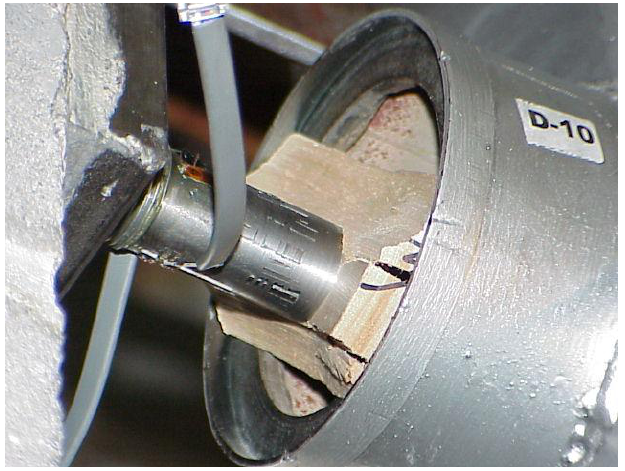
Figure 25. Damage to fuse 10 during test